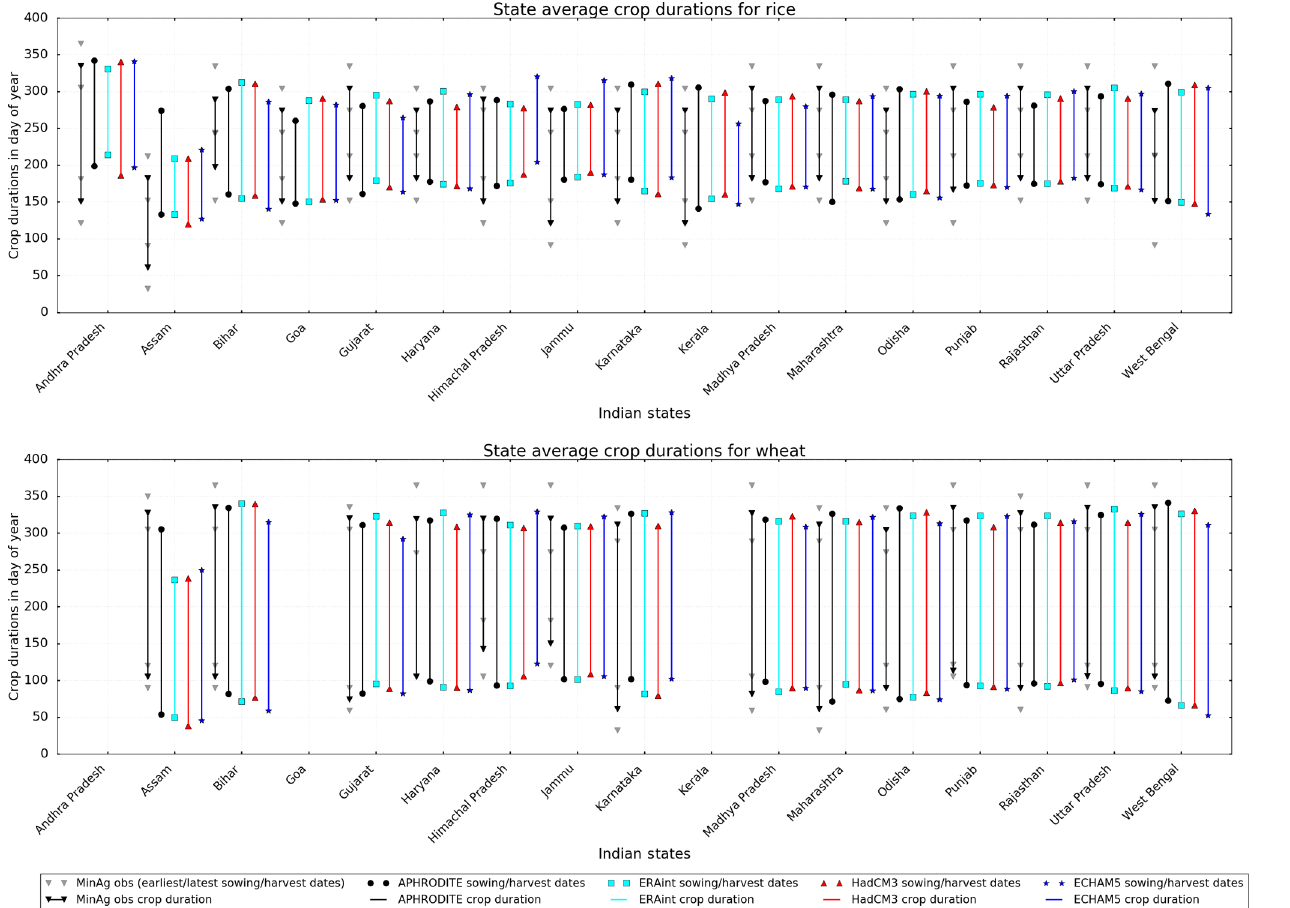
Figure 8. The state averaged durations for rice (upper panel) and wheat (lower panel) for each dataset are shown by the lines for each state together with the sowing and harvest dates shown by the different shapes at the end of each line. The MinAg observations are shown by the black line and downward triangles, with the paler triangles representing the full range of sowing and harvest days for that state. The APHRODITE observations are also shown by black lines and filled circles for the sowing and harvest dates. ERA-Interim is shown by cyan lines and squares, ECHAM5 by blue lines and asterisks, and HadCM3 by red lines and upward